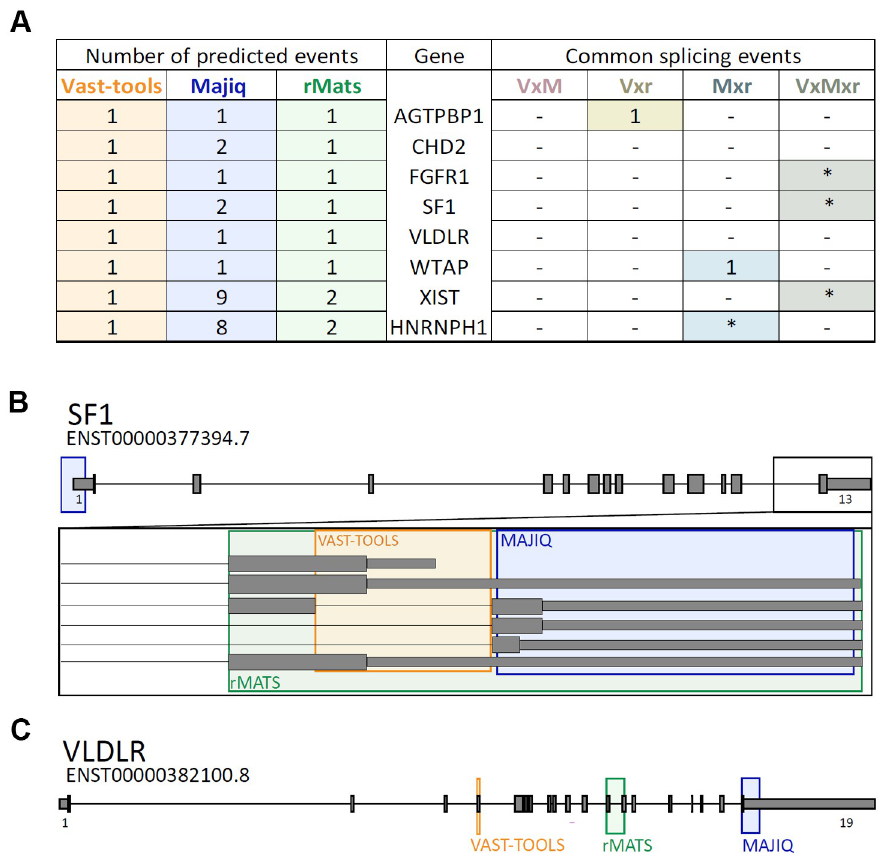
Fig 3. Analysis of genes with alternative splicing events predicted to be altered by ethanol in the human embryonic cortical tissue dataset. A) Number of alternative splicing events predicted for the 8 common genes by each bioinformatics tool (left side of the table). The number of splicing events predicted for at least two bioinformatics approaches is shown on the right side of the table. * Indicates that the alternative splicing events were not located at the same genomic coordinates, but they are contiguous or overlapped as shown in B. Comparison between bioinformatics predictions are coded as follow: VxM; VAST-TOOLS and MAJIQ matches, Vxr; VAST-TOOLS and rMATS matches, Mxr; MAJIQ and rMATS matches, VxMxr; VAST-TOOLS, MAJIQ, and rMATS matches. B) Diagram of the SF1 gene (ENST00000449182.1) illustrating the location of predicted splicing events. The lower part of the diagram represents a magnification of the 3´ end of the gene. C) Diagram of the VLDLR gene (ENST00000382100.8) illustrating the location of predicted splicing events. Blue boxes represent the coordinates of MAJIQ predicted events. Green boxes represent the coordinates of rMATS predicted events. Yellow boxes represent the coordinates of VAST-TOOLS predicted events. Intron sequences are represented by lines, exons by grey boxes, and UTR sequences by slim grey boxes. Gene diagrams are represented from 5´to 3´. Small numbers under the first and last exons indicate the number of the corresponding exon according to GENCODE V41.